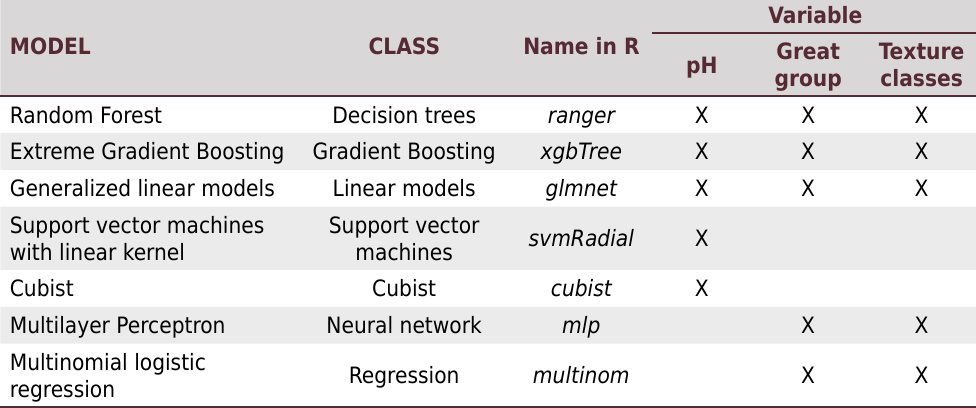
Table 2. List of ML models, family, corresponding name in the R library, and variables modeled